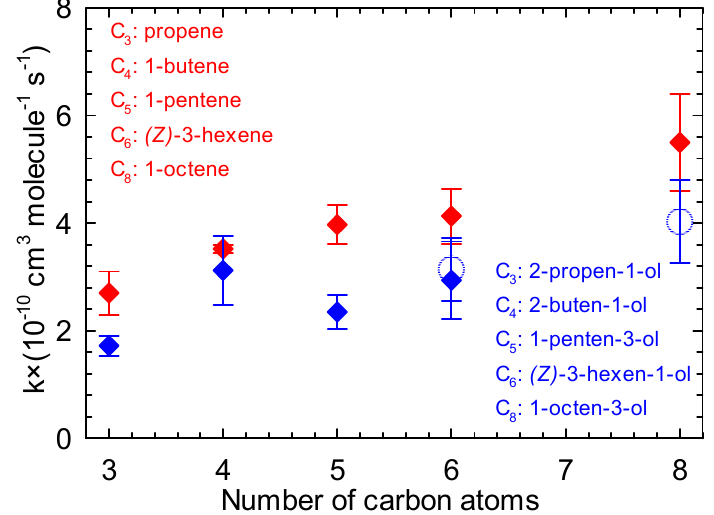
Figure 7. Rate constant of the reaction of Cl atoms with a series of alkenes (red) and alken-1-ols (blue) vs. number of carbon atoms (the open circles represent the values of the current study).